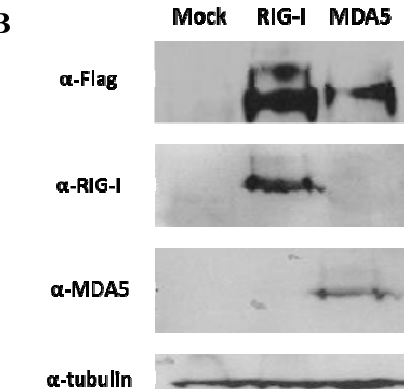
Figure 1. Induction of IFN- β promoter activity by the FMDV ncRNAs in HEK 293 cells expressing RLRs. ( A ) Cells (1 × 10 6 ) were co-transfected with 50 ng of pIFN β -FFLuc, 25 ng of pRL-TK, and increasing amounts of flag-RIG-I, flag-MDA5 or empty plasmid (1 and 10 ng). A constitutively active RIG-I, CARD2 (2 ng) served as positive control. After 24 h, cells were mock-treated or stimulated with 0.3 μ g (0.2 μ g/mL) or 3 μ g (2 μ g/mL) of the indicated ncRNA. Cells were harvested 24 h later and dual-luciferase assay was performed. The values represent the relative firefly luciferase activity normalized to Renilla luciferase activity and expressed as fold differences relative to mock-transfected cells. Data are representative of two independent experiments and error bars indicate mean +/ − SD; ( B ) Expression of RLRs in transfected 293 cells. HEK293 cells were transfected with 100 ng of flag-RIG-I or flag- MDA5. Forty-eight hours later, cell lysates were prepared and analyzed by immunoblot with anti-flag, anti-RIG-I, anti-MDA5 or anti- β -tubulin antibodies.